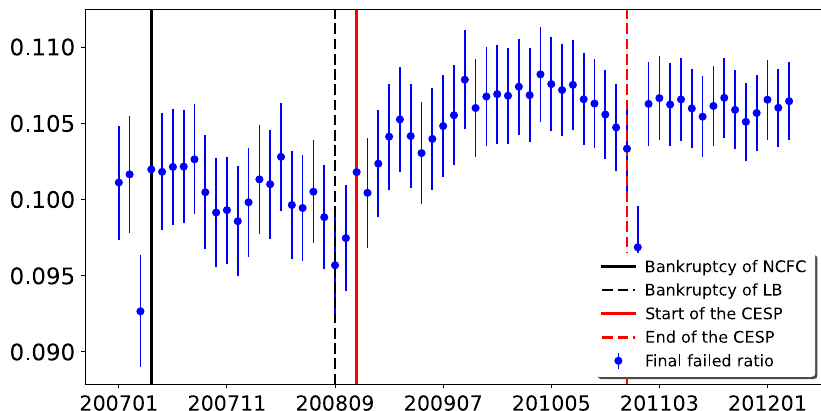
Fig. 5 Final failed ratio of random attack with the initial default ratio η equal to 0.05. The vertical axis represents the fi nal failed ratio. The horizontal axis represents time from January 2007 to March 2012. The solid and dashed lines represent major events. In each month, 5% nodes are randomly selected as the initial failures (default). The error bar represents one standard deviation. Source data are provided as a Source Data fi